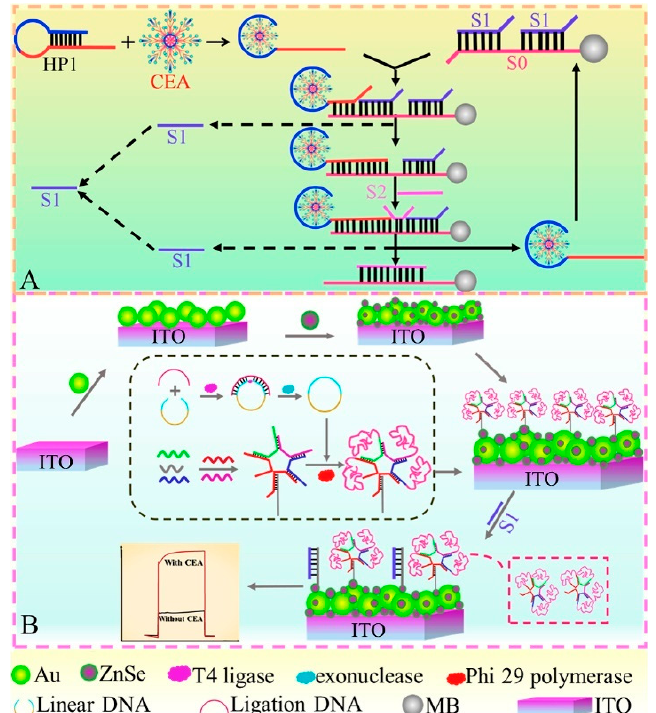
Figure 10. Schematic diagram of this proposed PEC biosensor for CEA determination. ( A ) Enzyme- free target cycling amplification strategy for generating S1; ( B ) Fabrication of the PEC “signal-off-on” biosensor based on ZnSe QDs/Au NPs and 3D DNA nanospheres. Reprinted with permission from ref. [124]. Copyright 2020 Elsevier.